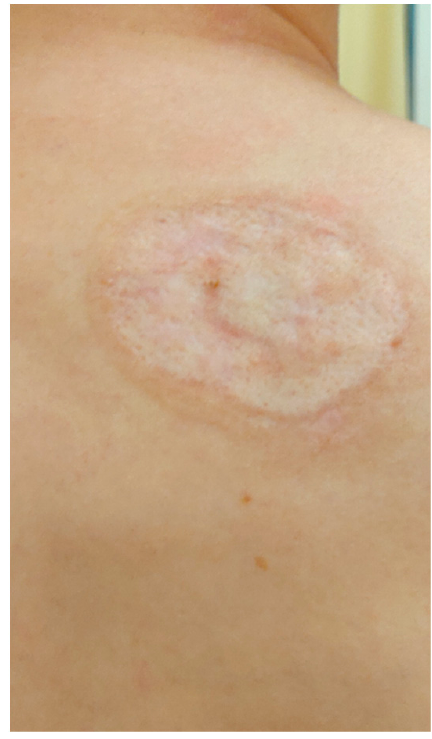
Figure 13. Lesions examined during the follow-up at the University Dermatological Outpatient Clinic (6 months after hospitalisation).